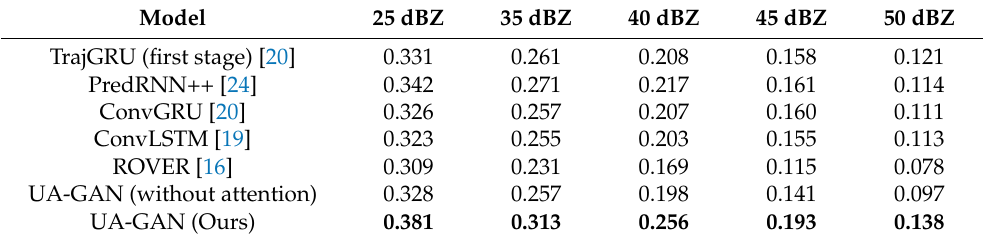
Table 10. Scores of CSI( ↑ ) at echo thresholds = 25, 35, 40, 45, and 50 dBZ.